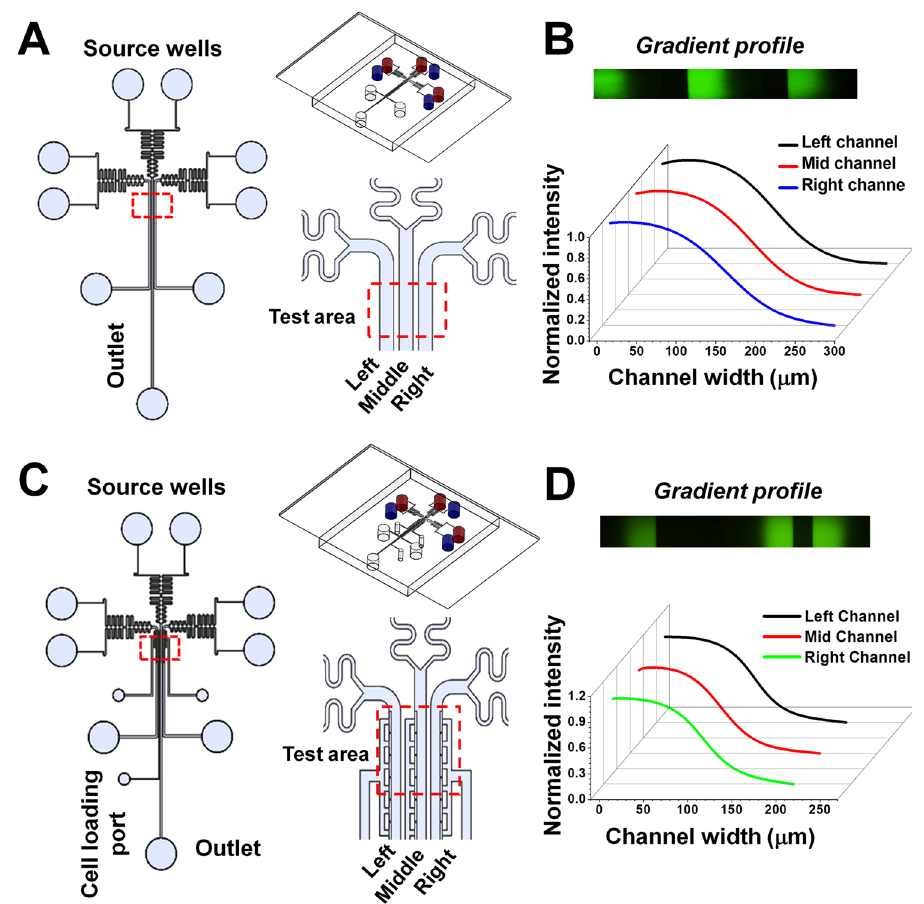
Figure 1. Illustration of the C 3 -Chip and D 3 -Chip. ( A ) Illustration of the C 3 -Chip design. The enlarged view shows the test area of the C 3 -Chip. The 3D view of the device is also shown. For a single chip, three gradient generating units are configured in parallel. Each unit has its independently controlled source wells and outlet. Cells can be loaded to each unit through the unit specific outlet. The test area (labeled by the red box) is the imaging field of the three parallel gradient channels (left, middle and right); ( B ) Identical gradient generation in the three parallel units of the C 3 -Chip; ( C ) Illustration of the D 3 -Chip design. The enlarged view shows the test area of the D 3 -Chip. The 3D view of the device is also shown. Similar to the C 3 -Chip, for a single D 3 -Chip, three gradient generating units are configured in parallel. Each unit has its independently controlled source wells, outlet and cell loading port. The test area (labeled by the red box) is the imaging field of the three parallel gradient channels (left, middle and right). The cell docking principle was described in details previously 28 and illustrated in Fig. S1B; ( D ) Identical gradient generation in the three parallel units of the D 3 -Chip. In the gradient plots, the edge of the gradient channel by the barrier channel for each unit is defined as the reference point. Thus, the gradient direction in the right unit is opposite to it in the left and middle units in the D 3